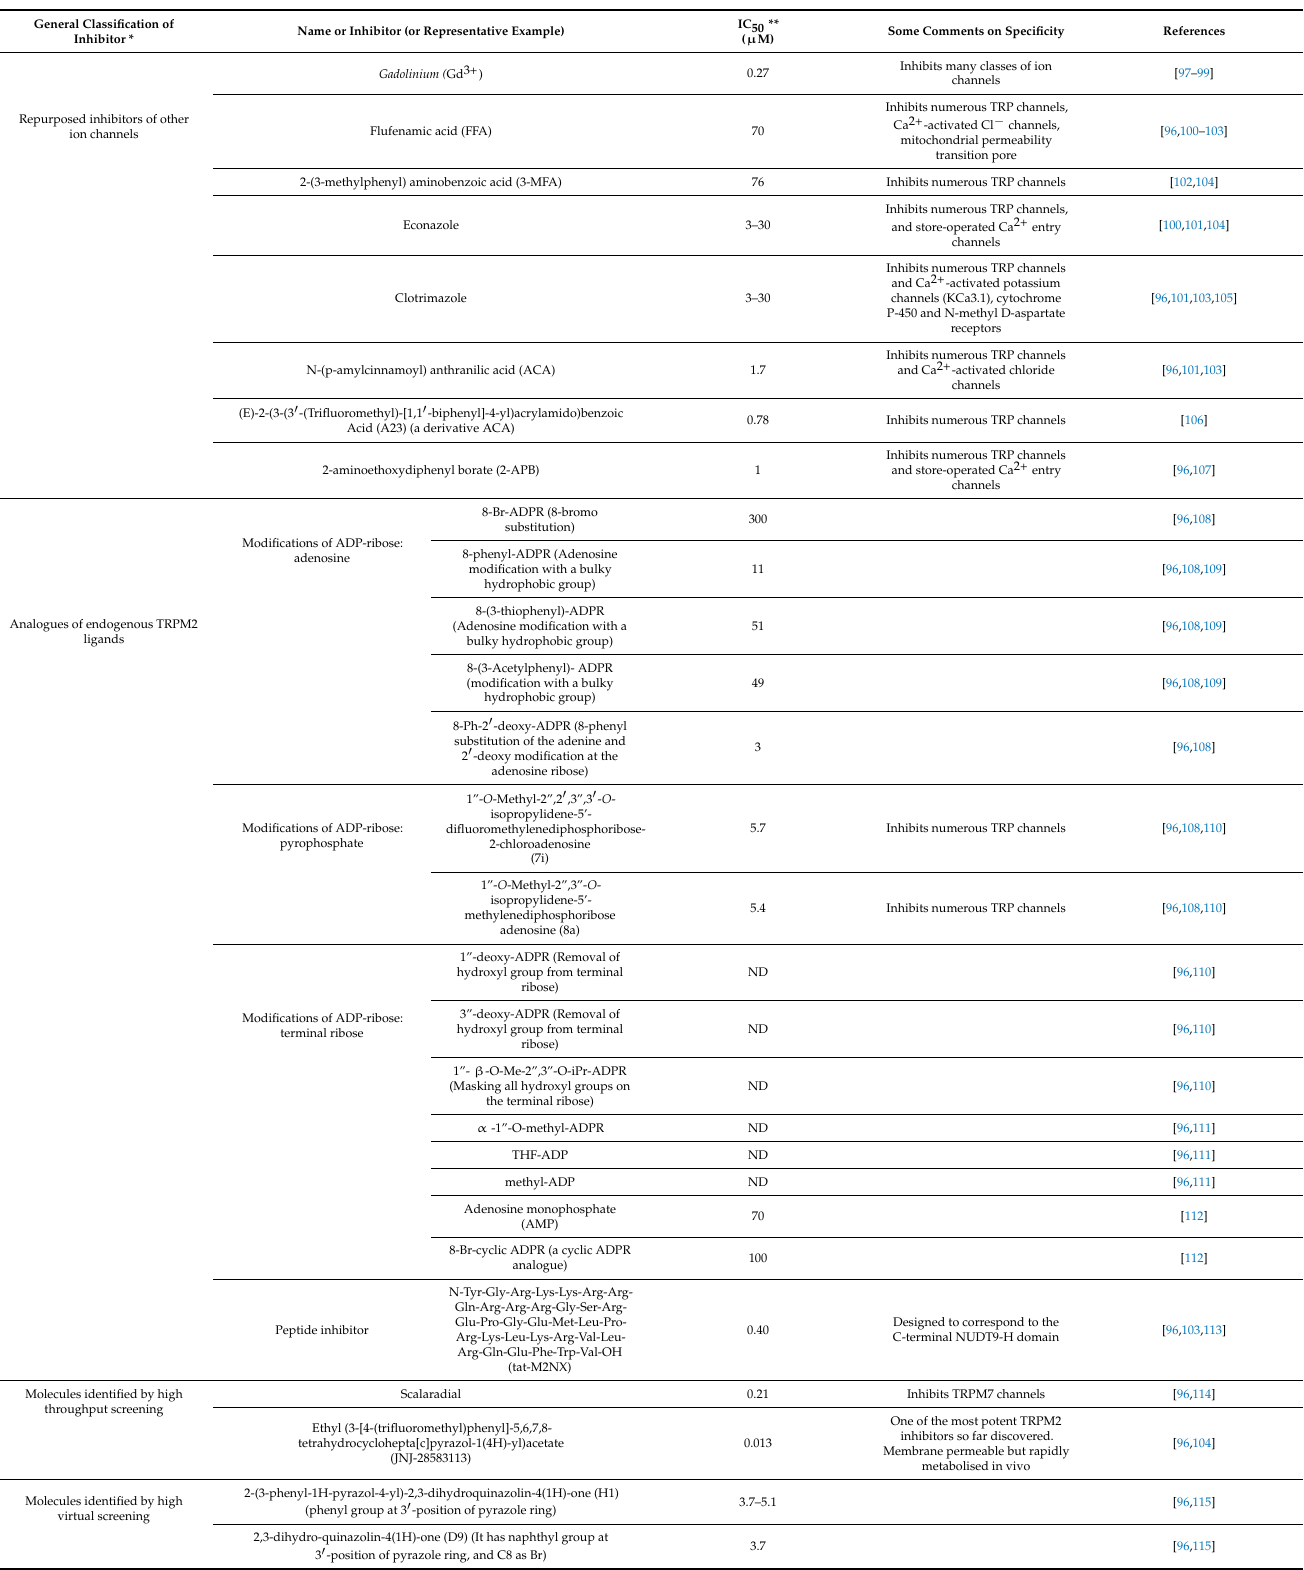
Table 1. Inhibitors of TRPM2